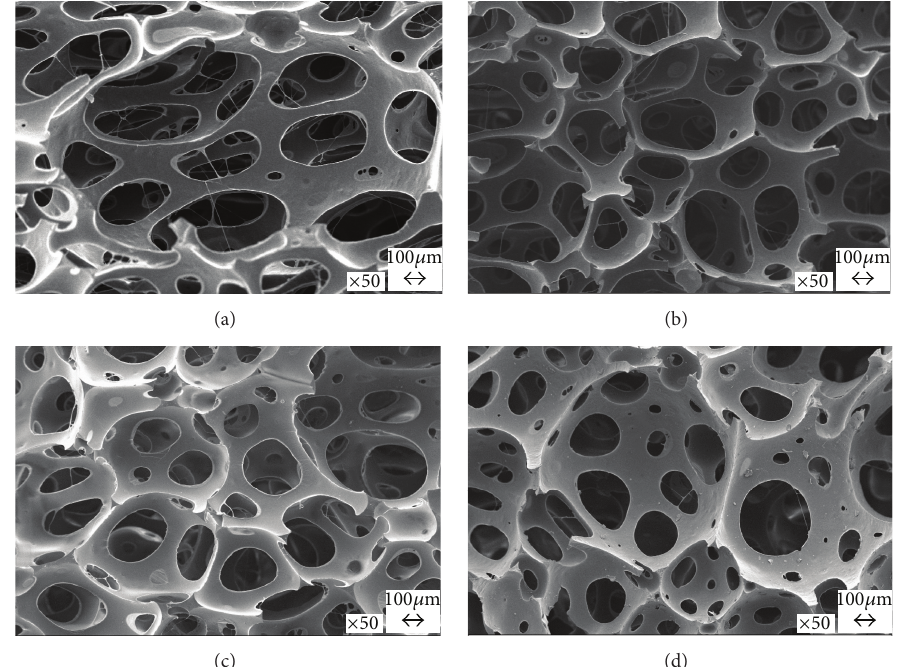
Figure 13: SEM micrographs of (a) palm-based PU foam and PU bionanocomposite foams with (b) 3 wt% OMMT (c) 5wt% OMMT and (d) 7 wt%